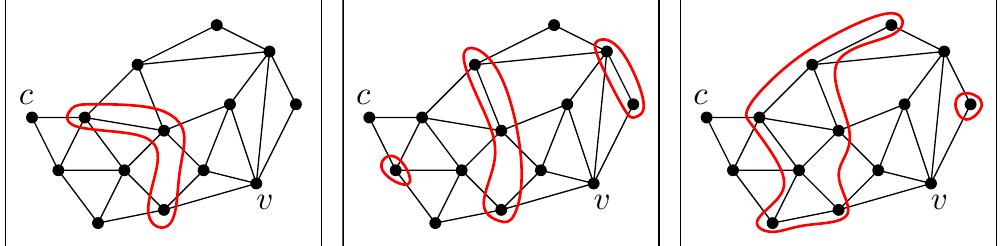
Figure 5: An example of an adjacency graph G with various ( c, v ) -separators (red): Every path from v to c contains at least one vertex of the respective